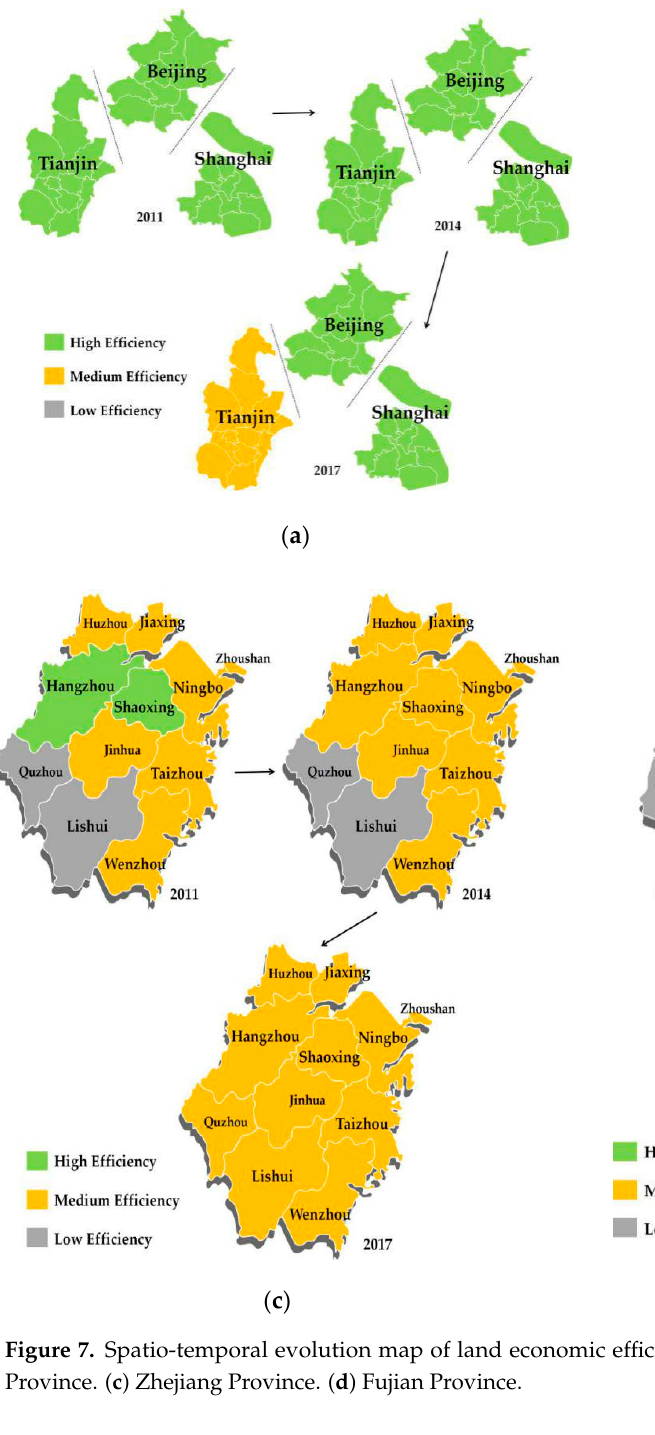
Figure 8. Spatio-temporal evolution map of land economic efficiency in Hebei Province.